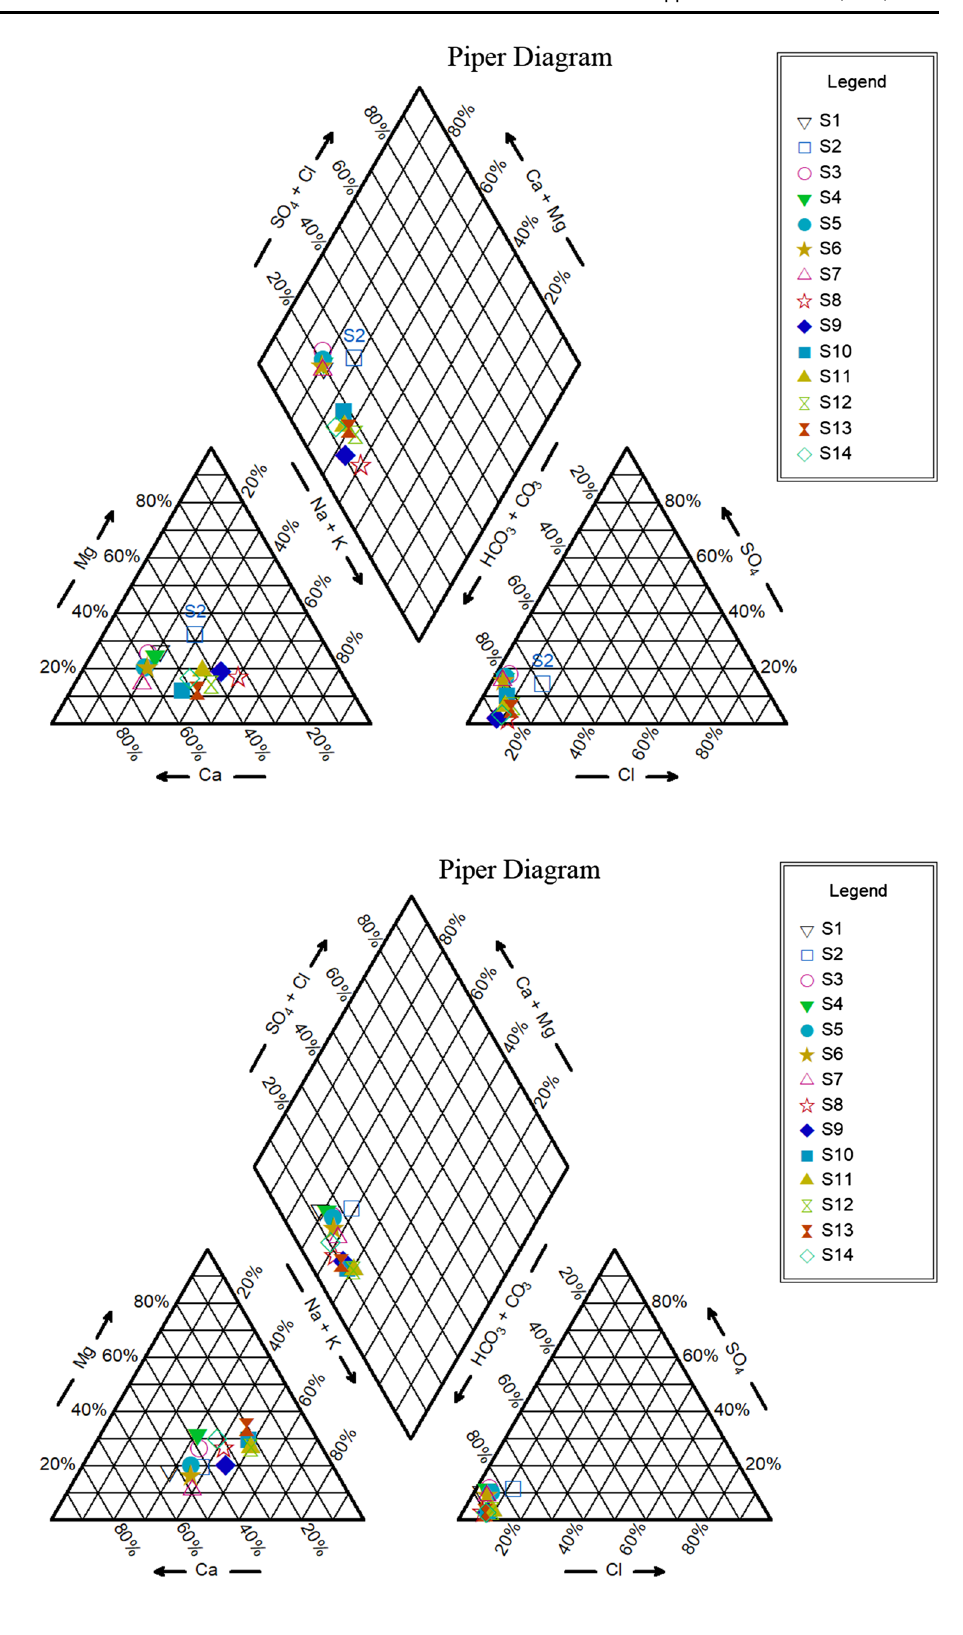
monsoon season 2016